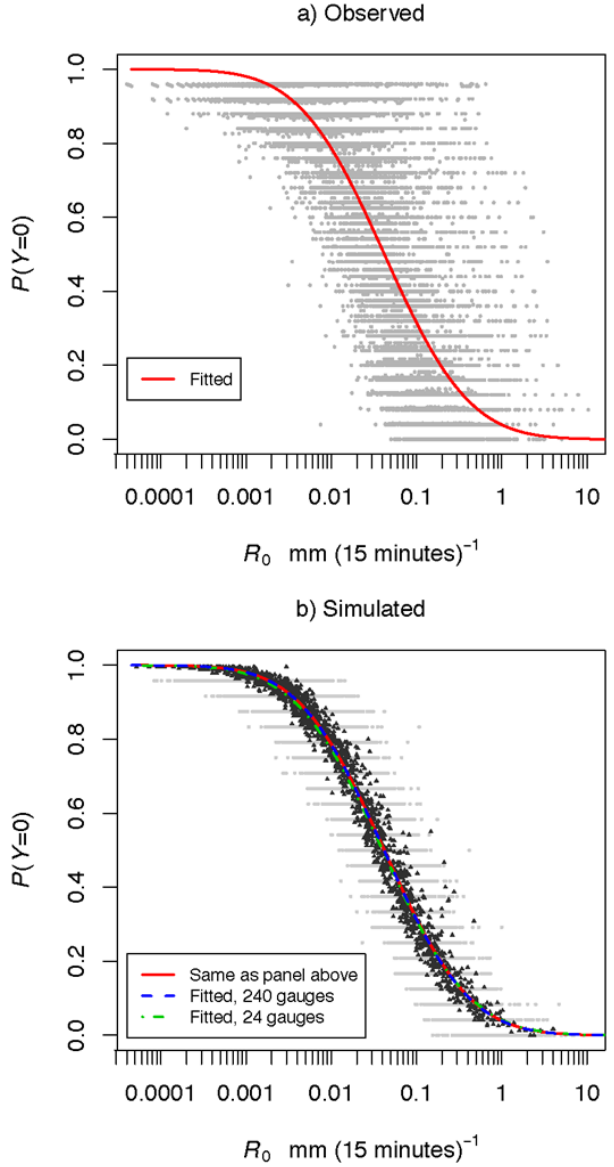
Fig. 3. Probability of zero rain at a rain gauge, or equivalently, P(Y =0), against large-scale areal-averaged rainfall rate R 0 for R 0 > 0. (a) : P(Y =0) as estimated from the observed rainfall (light gray symbols). (b) : P(Y =0) as estimated from rainfall simulated with Model SI σ /RI σ /LN. The dark gray symbols show the val- ues estimated using 240 “gauges”, represented by 240 grid cells in the finest resolution field (approximately 15 × 15cm). The light gray symbols show the parameter values estimated using 24 such gauges. The colored lines show Eq. (18) fitted to the observed and simulated